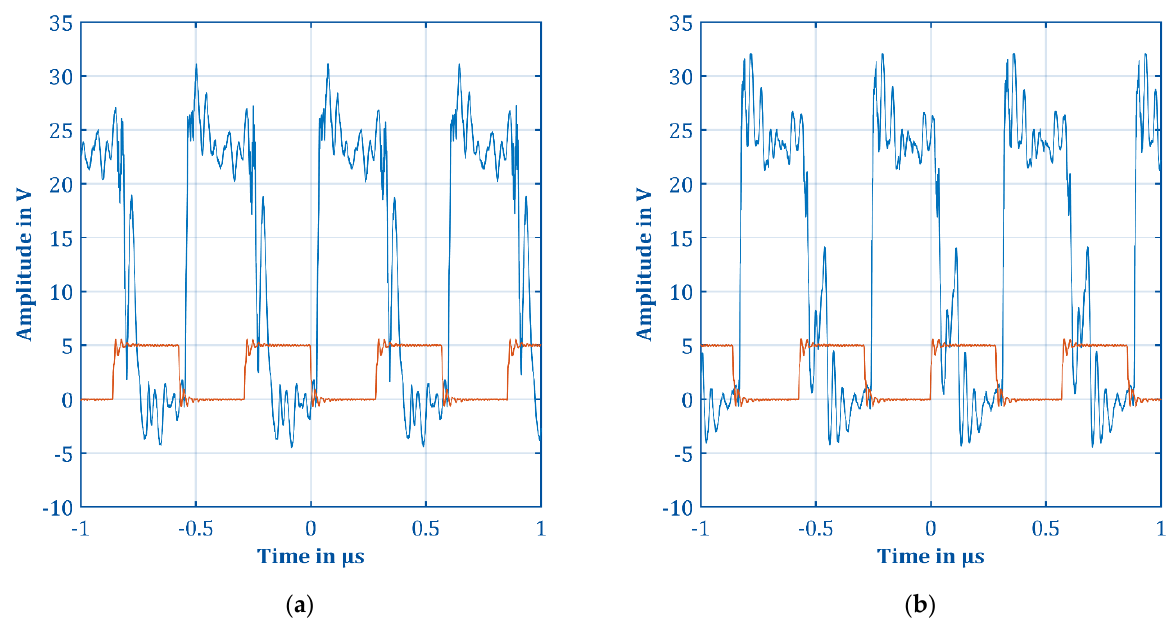
Figure A5. ( a ) Left output of the control electronics in blue with the corresponding input signal in orange from the Agilent 81150A function generator, at 1.75 MHz with the Square PCB transformer; all other transformers look almost identical. ( b ) Shows the inverted signal of the other output of the control signal at the same time; again blue is the output signal and orange the signal generator. Figure A6a,b show the voltage signals at the input of the improved voltage rectification and regulation electronics, see Figure 5, at a higher frequency of 1.75 MHz with the Square PCB transformer.